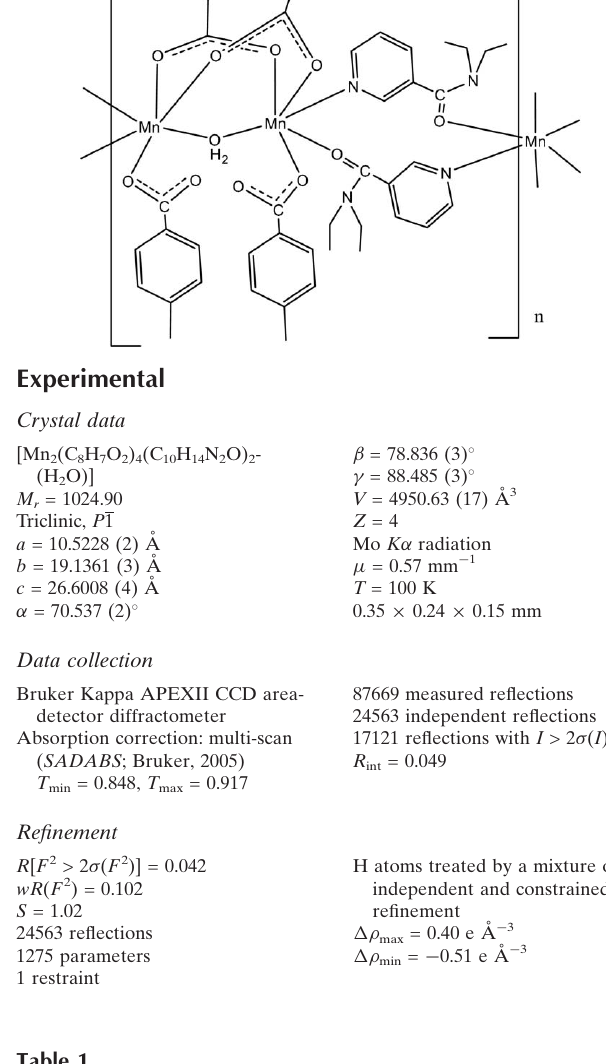
the crystal structure, each Mn II ion is coordinated by three PMB ligands, one water molecule and two symmetry-related N , N -diethylnicotinamide (DENA) ligands. Symmetry-related Mn II ions are bridged by the N and O atoms of symmetry- related DENA ligands, forming polymeric chains parallel to [100]. The coordination environmnts for the Mn II ions are slightly distorted octahedral. Intramolecular O—H (cid:2) (cid:2) (cid:2) O hydrogen bonds link bridging water molecules to the carboxylate O atoms of a neighboring polymeric chain. In the crystal structure, (cid:3) – (cid:3) contacts between benzene rings [centroid–centroid distance = 3.562 (1) A˚ ] and weak C— H (cid:2) (cid:2) (cid:2) (cid:3) interactions are also observed.